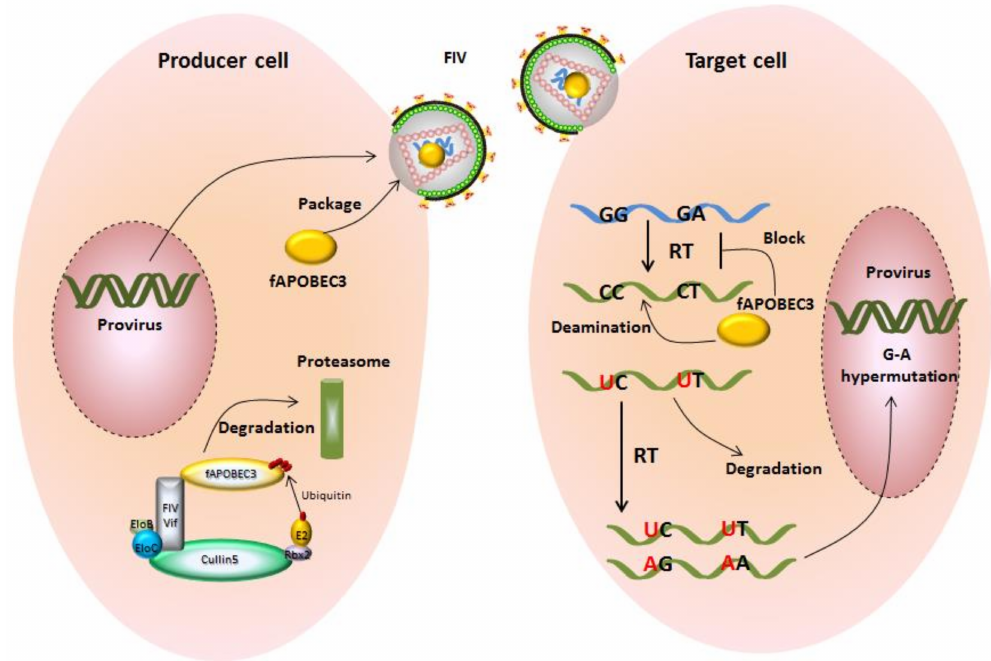
Figure 4. Feline A3s inhibit the replication of FIV and are counteracted by FIV Vif. In producer cells, A3s can be incorporated into virus particles and be delivered into target cell in the absence of Vif. During viral reverse transcription, virion-encapsidated A3s are able to catalyze the cytidine to uridine in viral cDNA. In the synthesis of next strand virus DNA, G-A hypermutations are produced on the coding strand.The uracil-containing viral cDNAs are partially degraded by cellular DNA repair enzymes, and the double-stranded DNAs harboring G-to-A hypermutations encode viral proteins with premature stop codons or mutated proteins. However, FIV Vif directly interacts with feline A3s and forms an A3-Vif-E3 ubiquitination complex, which induces A3 degradation by the proteasome pathway. In Vif expressing FIV infections, viral particels are produced that are mostly free of A3